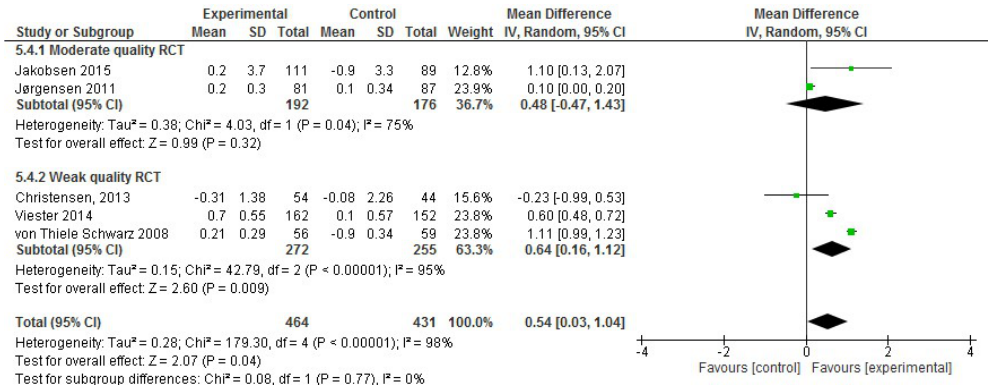
Figure 8. Forest plot of the e ff ectiveness of workplace interventions for improving employees’ work ability according to the quality of the studies.